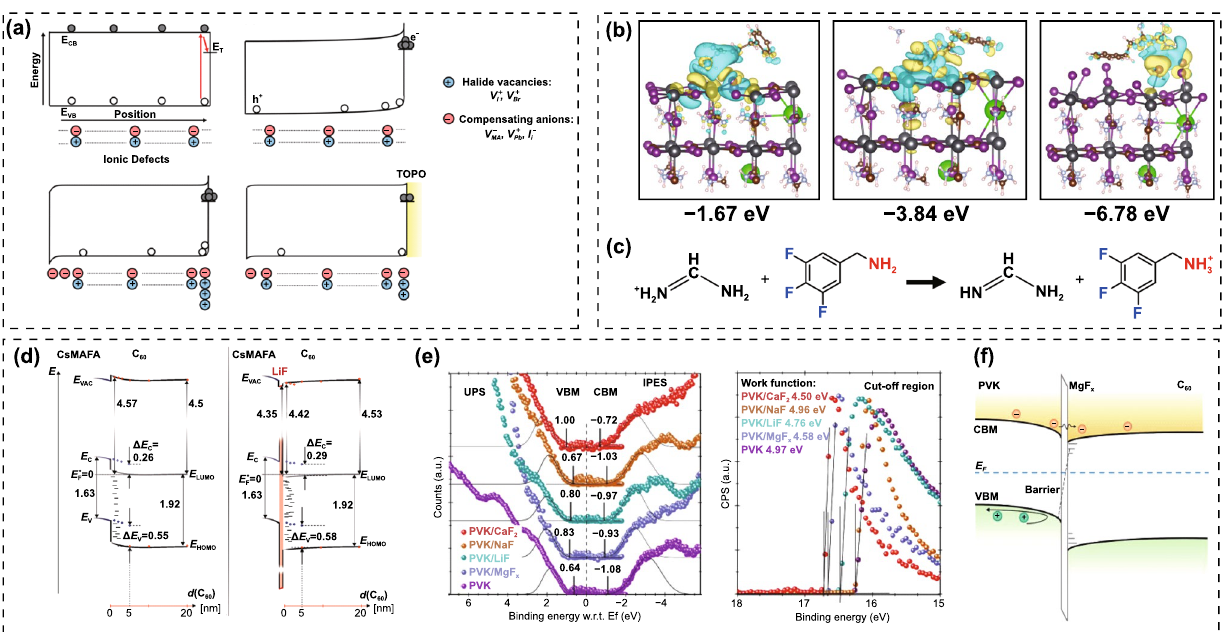
Fig. 14 a Annotated band diagrams produced from drift–diffusion simulations. Reproduced with permission from Ref. [223]. Copyright 2018, American Chemical Society. b Electron density differences for the PhenH + molecule on the PbI 2 , I-deficient and Pb-deficient surfaces and cor- responding binding energies. Reproduced with permission from Ref. [224]. Copyright 2021, Elsevier. c Proton-transfer reaction between FA cation and TFBA from Ref. [205]. Copyright 2022, Wiley–VCH. d Energy level alignment at the CsMAFA/C 60 interface with and without LiF interlayer. Reproduced with permission from Ref. [227]. Copyright 2022, Wiley–VCH. e Valence band and photoelectron cut-off region of the perovskite and perovskite/interlayers f Energy level diagram of the perovskite/C 60 interface with MgF x insertion layer. Reproduced with permis- sion from Ref. [13]. Copyright 2022, Science Publishing